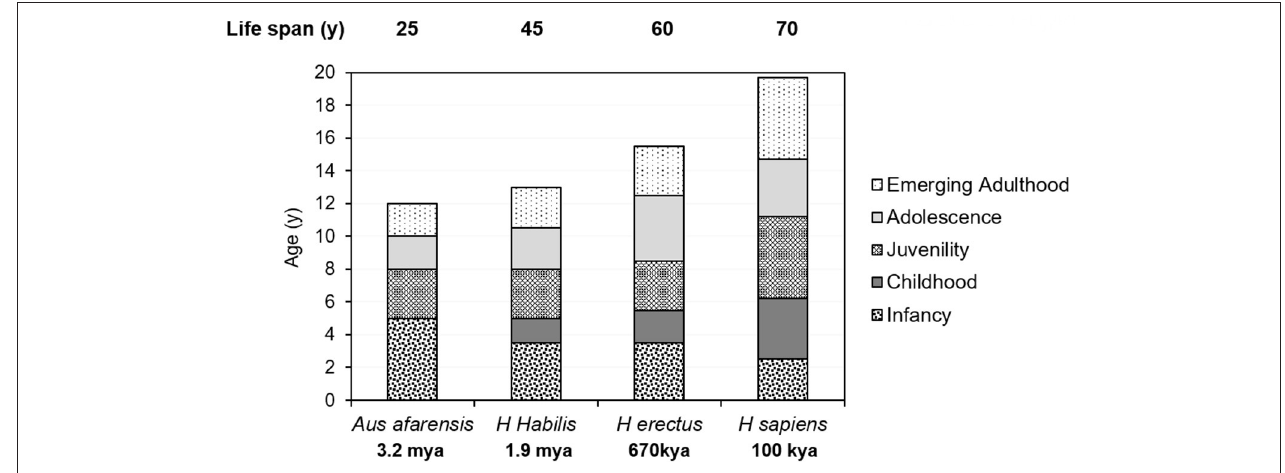
FIGURE 3 | Comparison of the life-history stages and the newly defined emerging adulthood of Australopithecus afarensis , Homo habilis, H. erectus , and H. sapiens